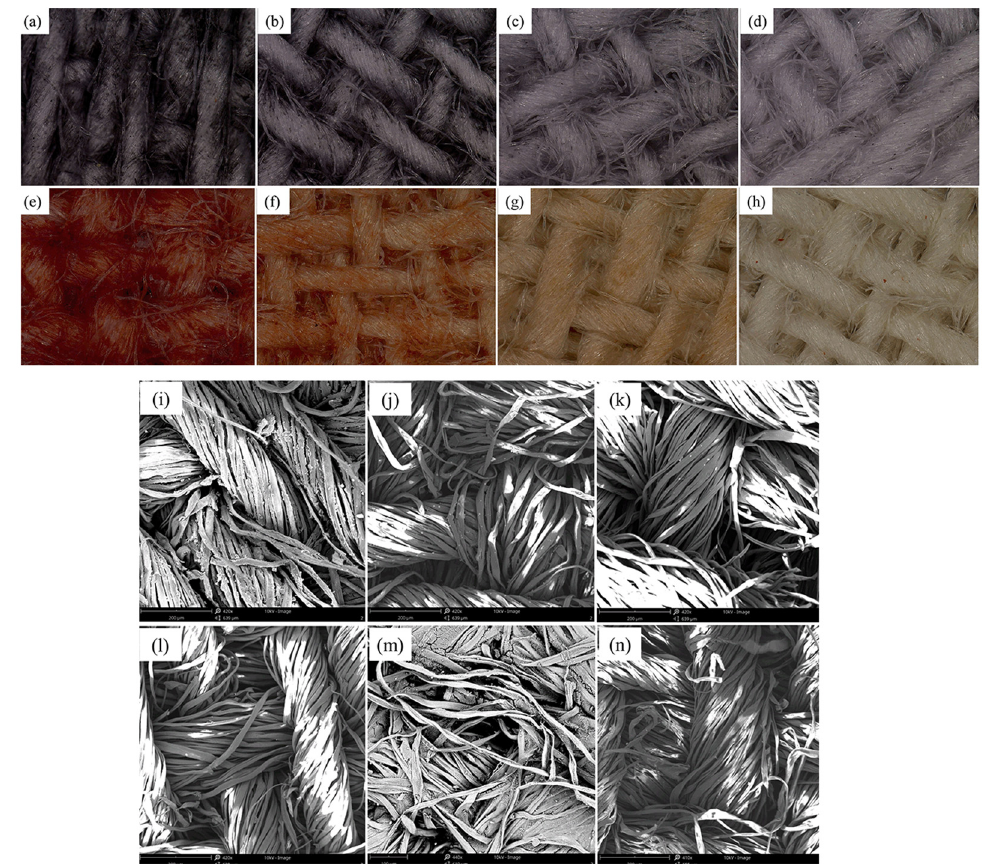
Figure 1. Surface image of protein-fouling cloth. ( a ) Unwashed protein-fouling cloth (500×). ( b ) Protein-fouling cloth after washing with alkaline protease (500×). ( c ) Protein-fouling cloth after washing with keratinase (500×). ( d ) Protein-fouling cloth after washing with trypsin (500×). Surface image of blood-dirty cloth ( e ) Unwashed blood-dirty cloth (500×). ( f ) Blood-dirty cloth after washing with alkaline protease (500×). ( g ) Blood-dirty cloth after washing with keratinase (500×). ( h ) Blood-dirty cloth after washing with trypsin (500×). SEM images of protein-fouling cloth before and after washing. ( i ) Unwashed protein-fouling cloth (420×). ( j ) Protein-fouling cloth after washing with alkaline protease (420×). ( k ) Protein-fouling cloth after washing with keratinase (420×). ( l ) Protein-fouling cloth after washing with trypsin (420×). ( m ) Blood-dirty cloth after washing with keratinase (440×). ( n ) Blood-dirty cloth after washing with trypsin (410×).